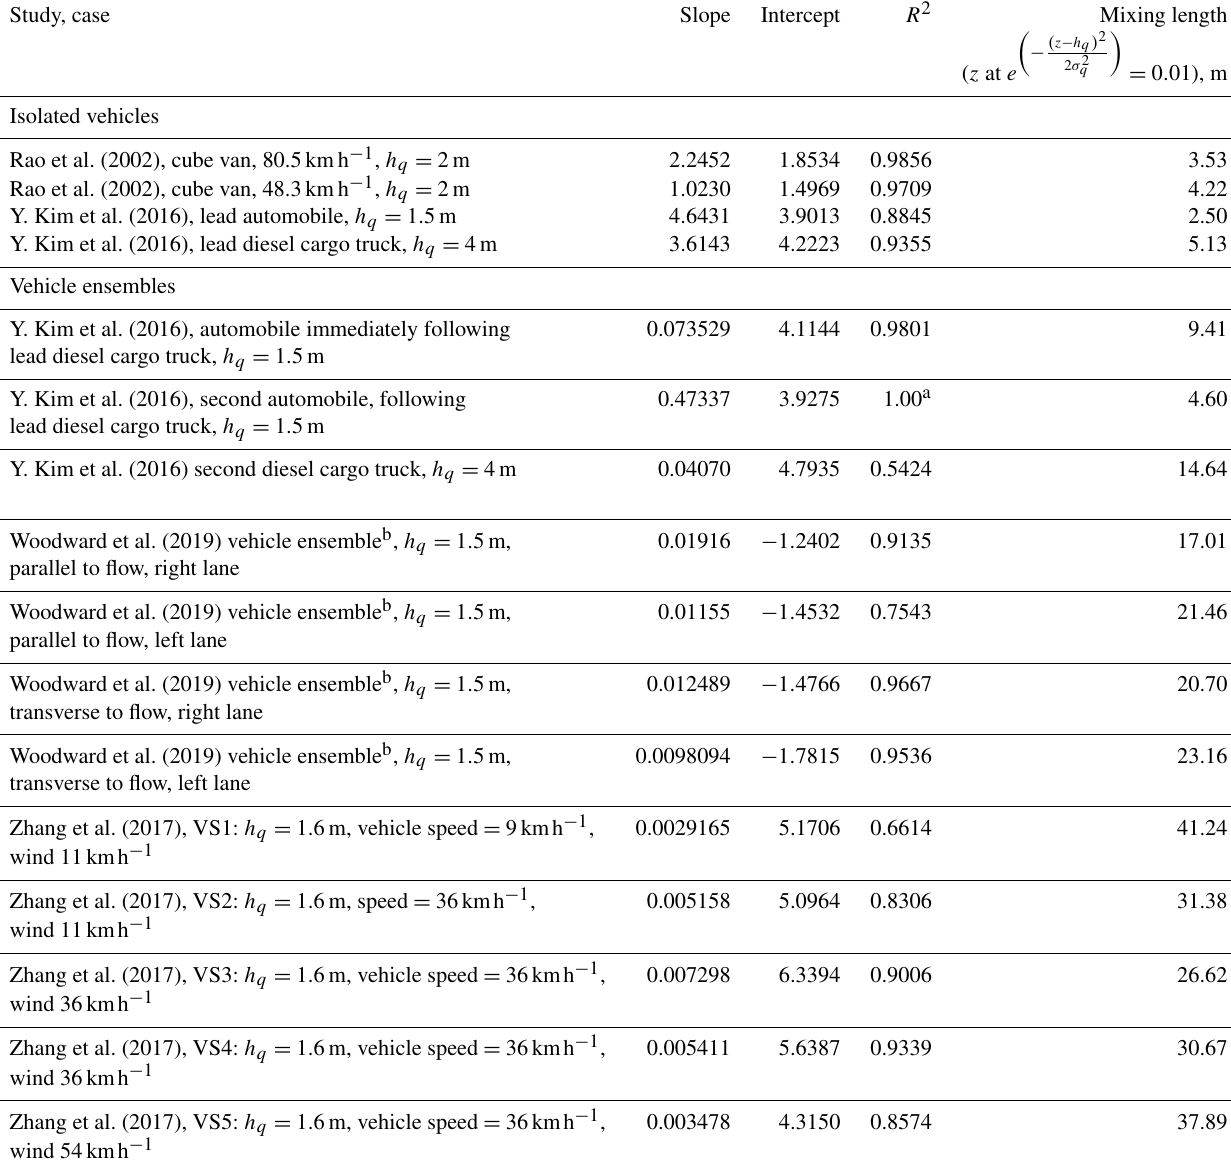
Table 1. Gaussian distribution fits of VIT TKE drop-off with height, from observation and CFD studies. Study,